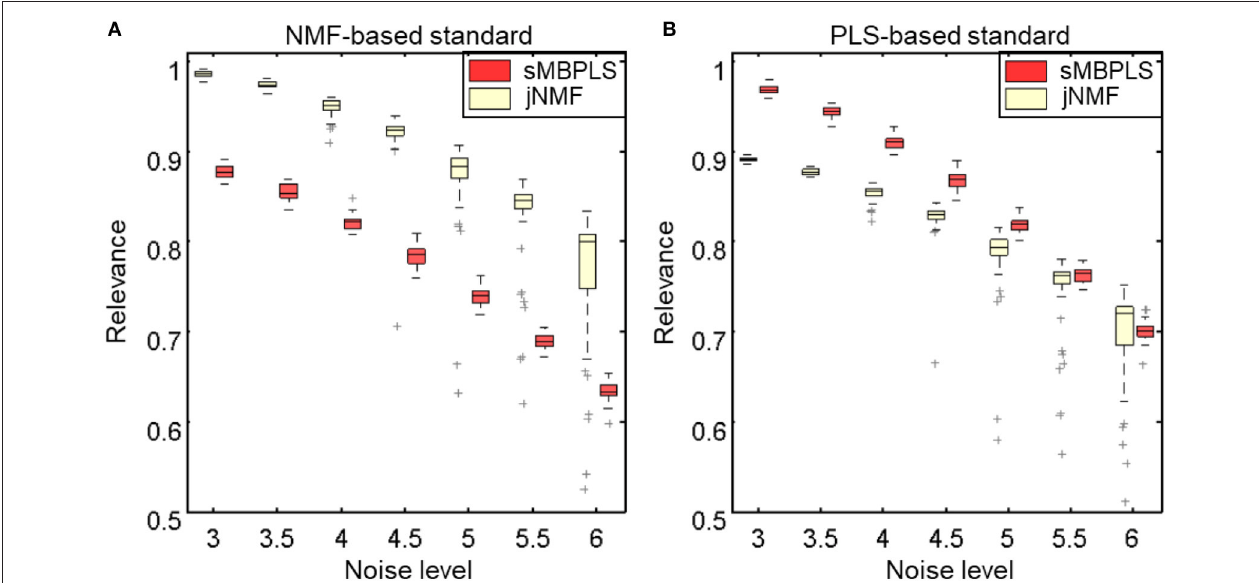
FIGURE 3 | Comparison of jNMF and sMBPLS in terms of relevance scores under two types of golden standards, derived by the characteristics of NMF method (A) and PLS method (B) . Here, we apply jNMF and sMBPLS to 50 sets of simulated data matrices for each level of data noise, respectively. negatively correlated with the other 50 samples. As a result, sMBPLS discovers all these 90 samples as components of the second co-module, while jNMF just identifies the last 50